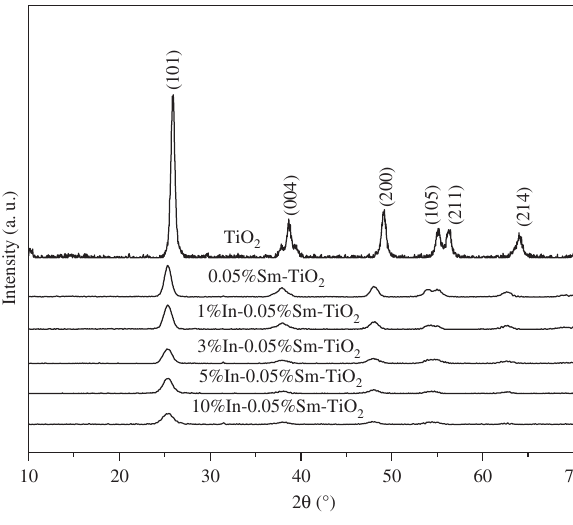
and pure TiO 2 2